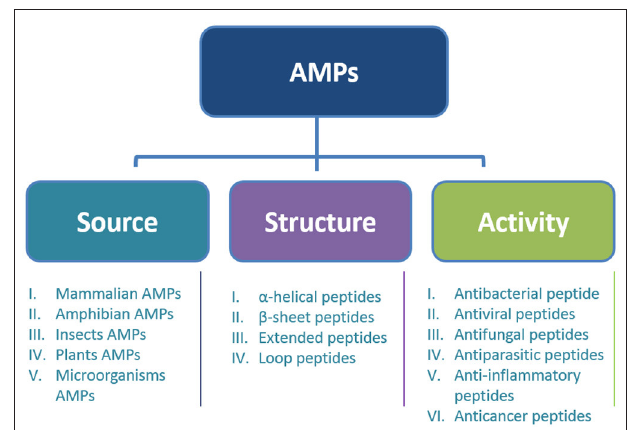
FIGURE 1 | Classification of